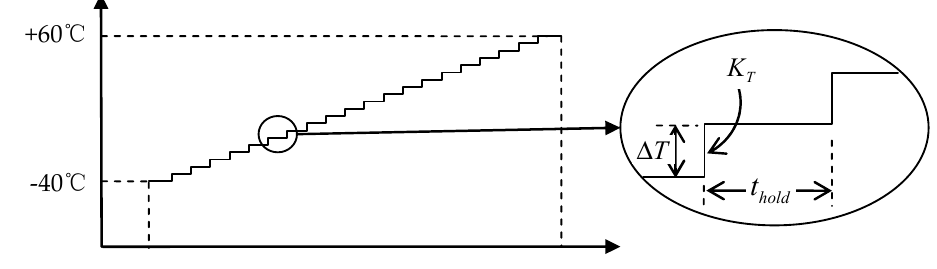
Figure 5. The setting curve of the dynamic climate chamber.